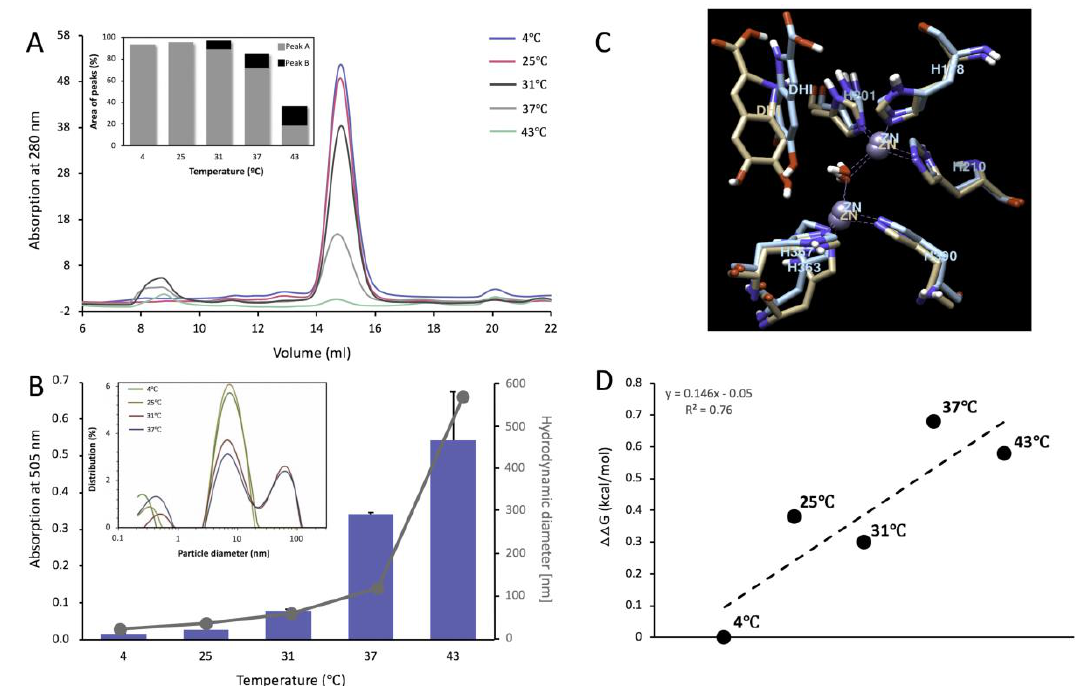
Figure 6. Tyrp1tr analyzed at pH 5.5 mimicking conditions within the melanosome. Panel A : Graph shows the chromatography profiles of Tyrp1tr pre-incubated for 24 h, at 4 (blue line), 25 (pink line), 31 (black line), 37 (grey line), and 43 ◦ C (green line) and eluted from the Superdex 200 Increase GL 10 / 300 column. The insert shows the % of the peak’s area calculated from the Unicorn 7.0 software (GE Healthcare Bio-Sciences, Pittsburgh, PA, USA), as well as the ratios between Peaks A (grey bars) and Peaks B (black bars). Panel B : Tyrp1tr diphenol oxidase activities (blue bars) measured using DHICA as a substrate in the presence of MBTH after pre-incubation for 180 min at 4, 25, 31, 37, and 43 ◦ C and monitored by measuring the IQCA / MBTH formation at 505 nm. Hydrodynamic diameter (grey dots) was measured after pre-incubation of Tyrp1tr for 180 min at 4, 25, 31, 37, and 43 ◦ C. The insert shows particle diameter distribution by intensity for Tyrp1tr at 2 mg / mL measured at temperature 4, 25, 31, 37, and 43 ◦ C. Panel C : The superposition of Tyrp1 atomic models was obtained by 6 ns molecular dynamics equilibration at 4 ◦ C (beige) and 43 ◦ C (blue). The best molecular poses of DHICA molecules (labeled as DHI) for each model are shown. Only Zn-atoms and histidine residues are presented in each case. Panel D : Free energy changes, ∆∆ G of Tyrp1 DHICA docking at pH 5.5 and di ff erent temperatures. ∆∆ G was defined as a di ff erence between Gibbs free energy changes of the DHICA / Tyrp1 complex and free energy changes for individual molecules and presented relative to that of 4 ◦ C